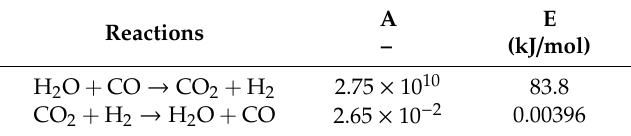
Table 2. Kinetic parameters of a water–gas shift